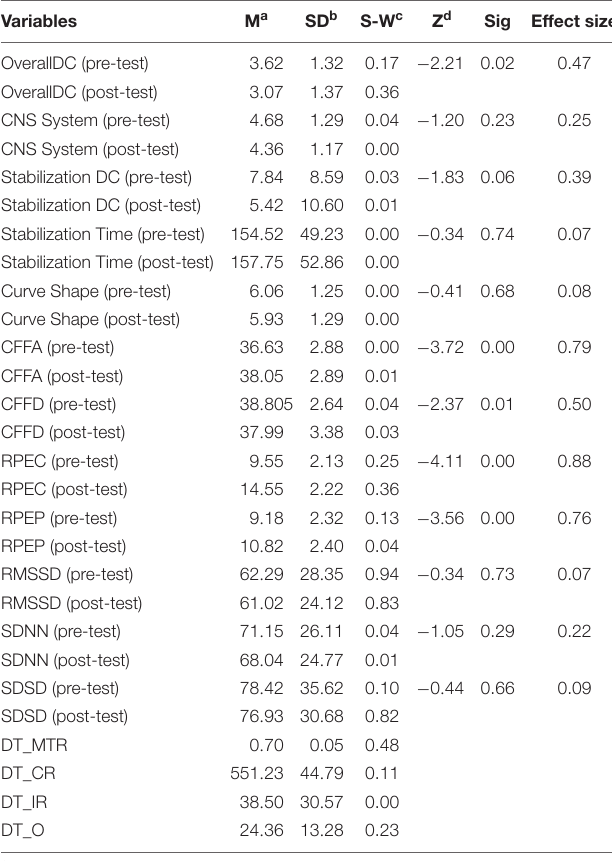
TABLE 2 | Descriptive analysis of the measured